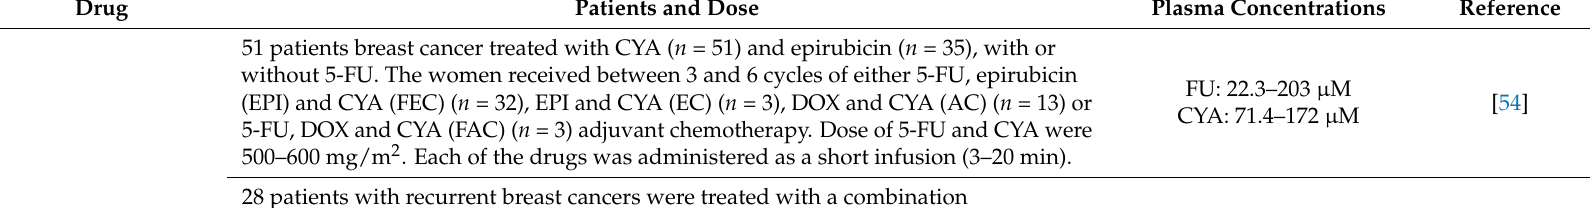
Drug Patients and Dose Plasma Concentrations